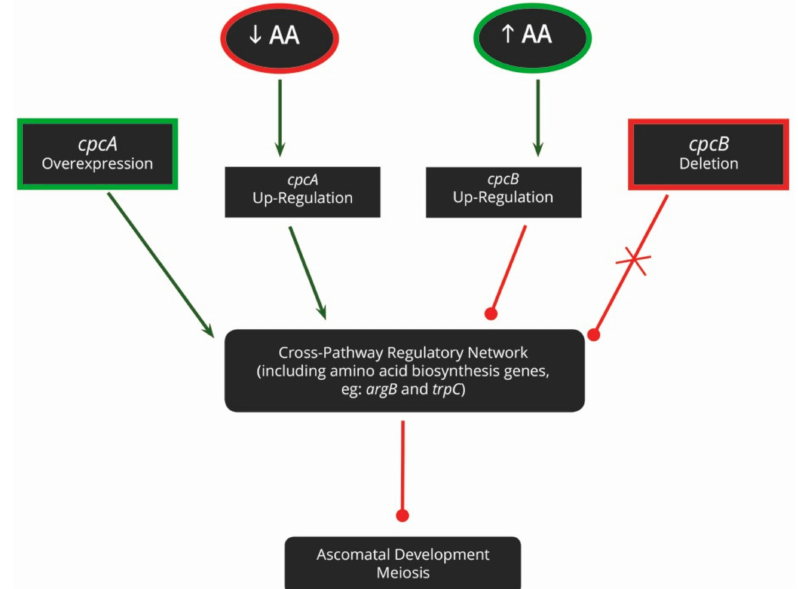
Figure 3. The involvement of the cross-pathway regulatory network (CPRN) during sexual reproduction in A. nidulans . In the absence of amino acids, cpcA is up-regulated, thereby activating the CPRN. This pathway subsequently inhibits the onset of sexual reproduction. In contrast, when amino acids are available, cpcB is up-regulated and the CPRN is inhibited. This results in sexual development. Either the overexpression of cpcA or the deletion of cpcB can activate the CPRN, by simulating amino acid deficiency, and thus also inhibit sexual reproduction. Shapes with green outlines indicate conditions under which sexual reproduction is directly or indirectly activated. Those with red outlines indicate conditions which directly or indirectly repress sexual reproduction. Green arrows indicate activation of a particular pathway, while red lines terminating in circles indicate